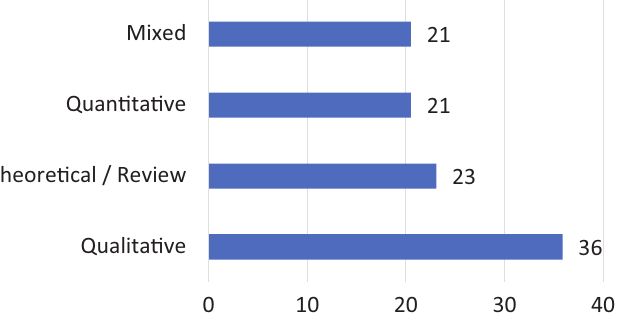
Figure 4. Percentage of studies by